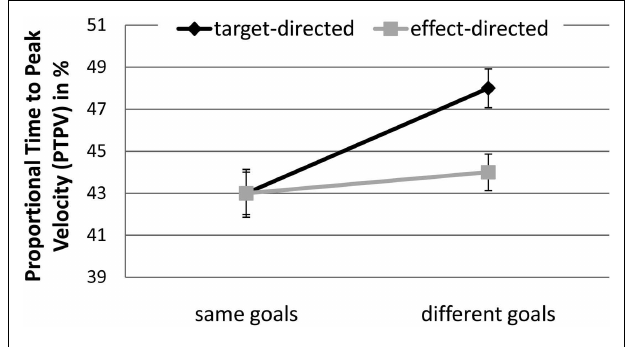
FIGURE 5 | Experiment 2: means and confidence intervals of ProportionalTime to PeakVelocity in % (PTPV).